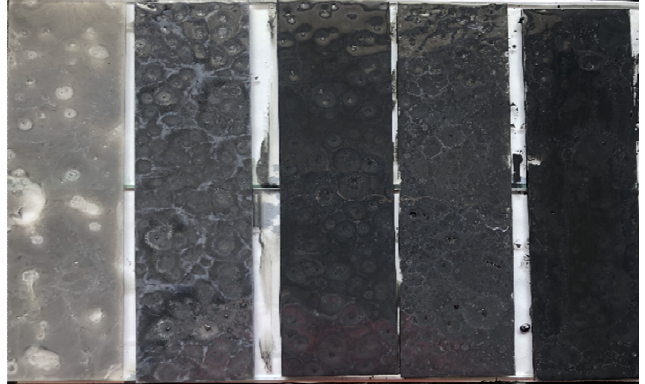
Figure 5. Composite materials in different proportions (from left to right: 0.1, 0.3, 0.6, 0.5, 0.7).